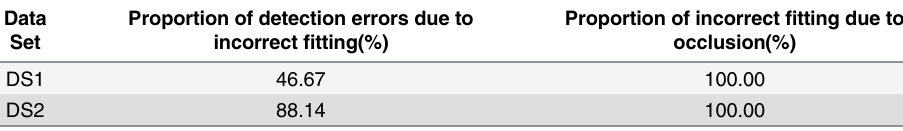
Table 3. Evaluation of fish body